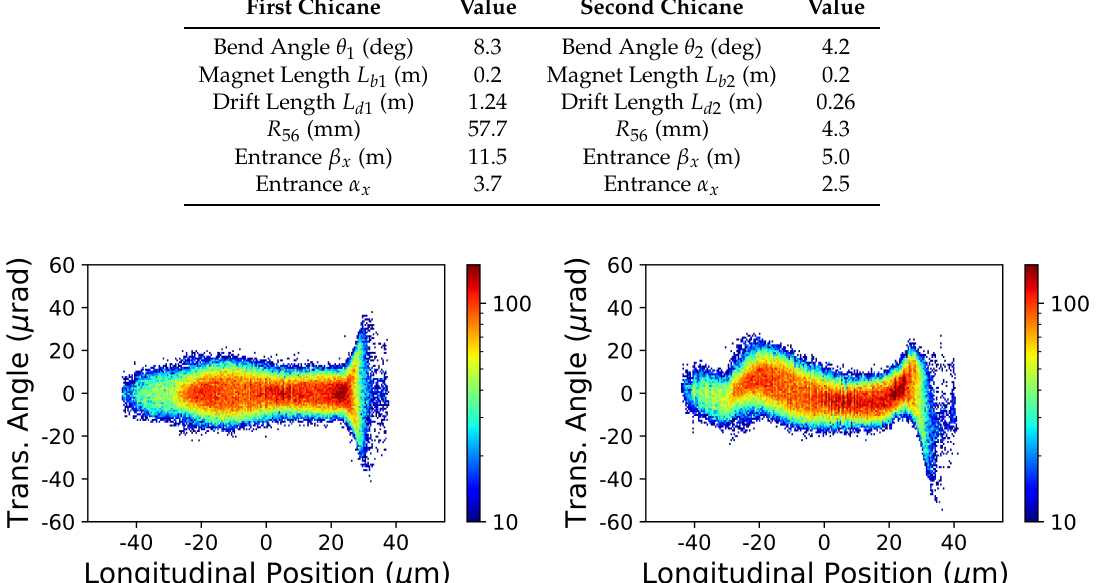
Figure 6. The variation of transverse angle with longitudinal bunch coordinate are shown for the S-shaped chicane design for the first compressor, on the left without CSR effects and with CSR effects on the right. In both plots, the beam head is to the